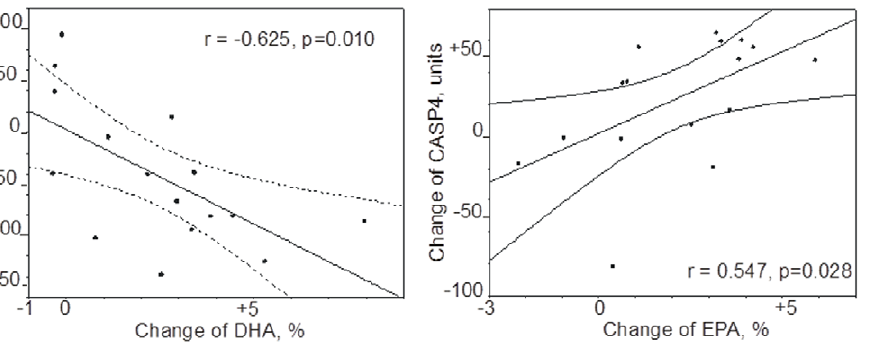
Figure 3. Correlation between changes of plasma docosahexaenoic acid (DHA) and eicosapentaenoic acid (EPA) and gene expression. Changes of plasma DHA, left, and EPA, right, and changes of expression (signal log ratio units) for the ANAPC5 (left) and CASP4 (right) genes.